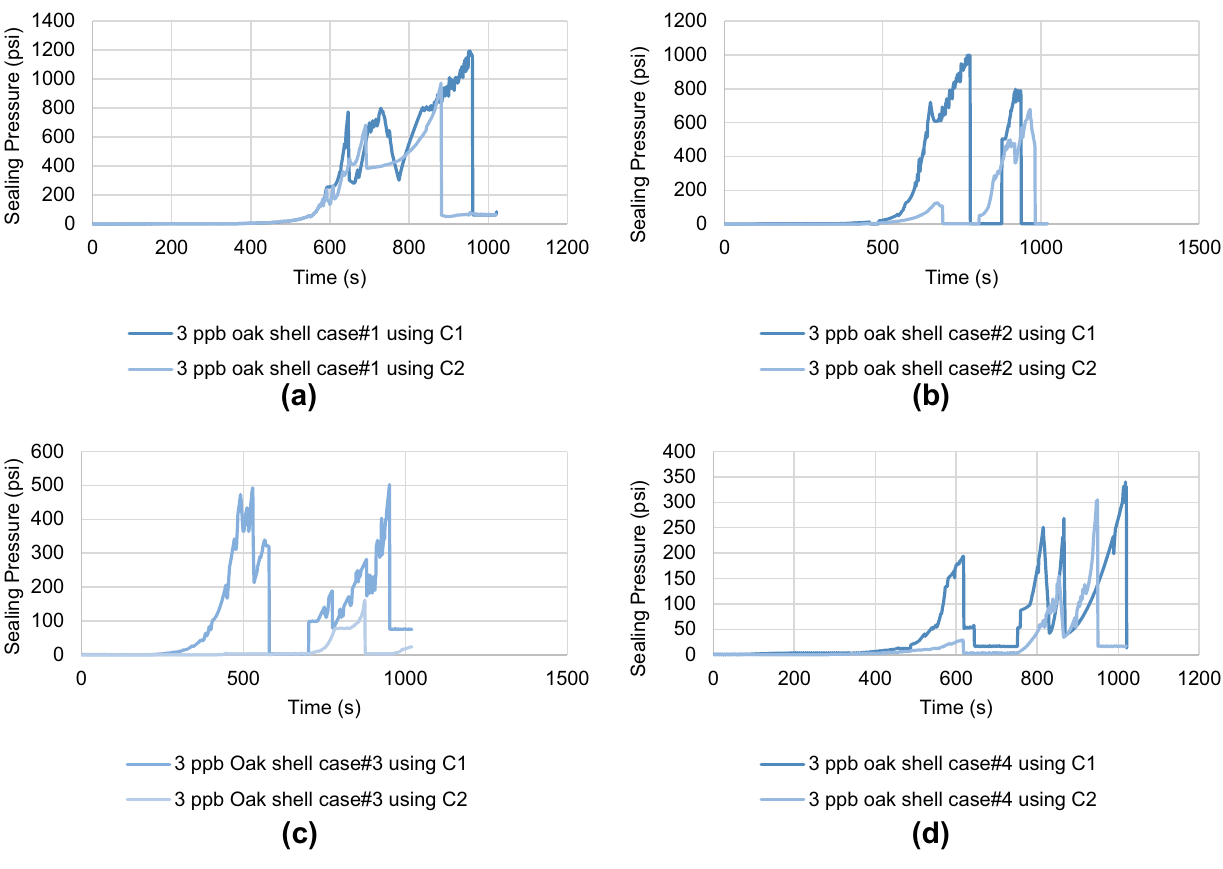
Fig. 23 HPA Pressure vs. Time plot for 3 ppb Oak Shell showing maximum sealing pressure at different fracture widths, a case#1, b case#2, c case#3, d